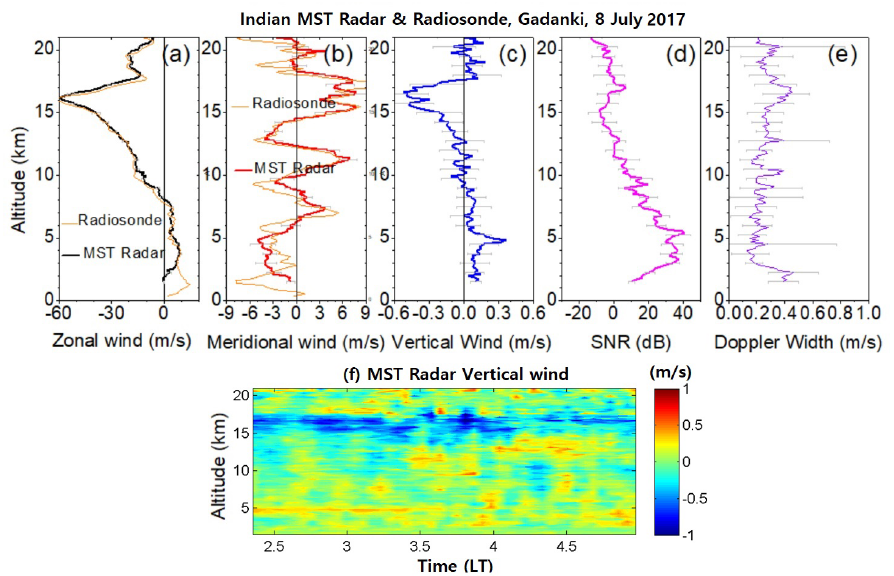
Figure 9. Profiles of (a) zonal wind, (b) meridional wind, (c) vertical wind, (d) signal-to-noise ratio (SNR), and (e) Doppler width obtained from Indian MST radar on 8 July 2017 and averaged during 02:30 to 03:30LT. Horizontal bars show standard deviation. Radiosonde-observed zonal and meridional winds are also superimposed in the respective panels. (f) Time–altitude section of vertical wind obtained from Indian MST radar during the radiosonde launch time.